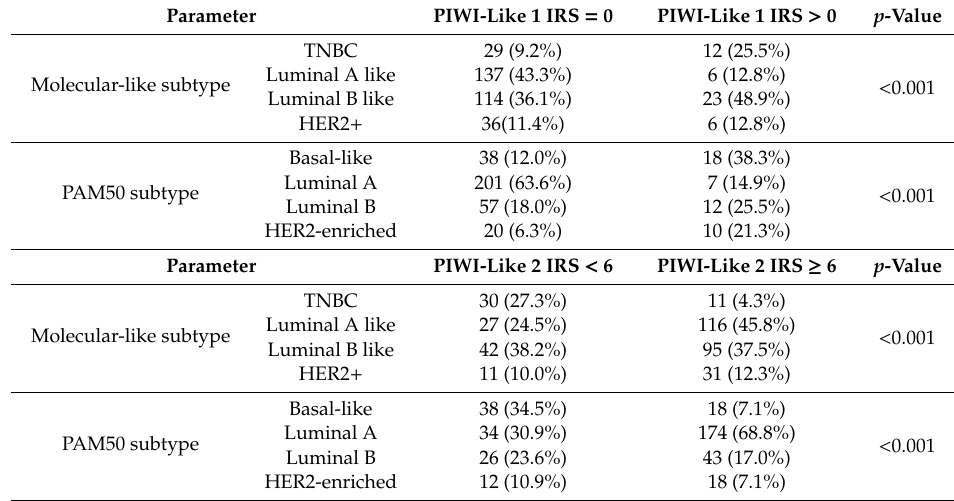
Table 4. Distribution ( n and %) of PIWI-like 1 IRS and PIWI-like 2 IRS by molecular-like subclasses and PAM50 subtypes including the p value of the chi-squared test.